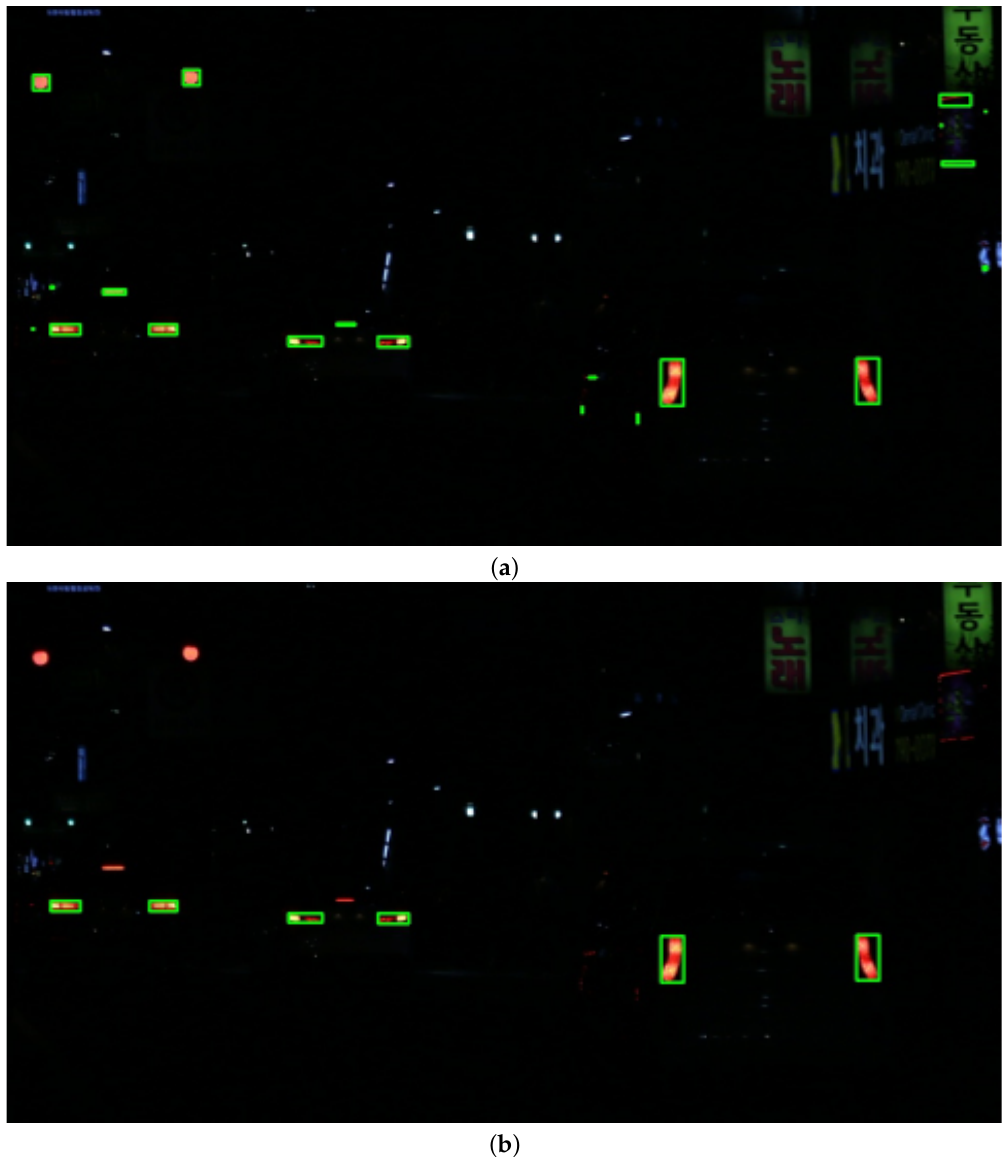
Figure 11. Detection result: ( a ) before taillight verification; ( b ) after taillight